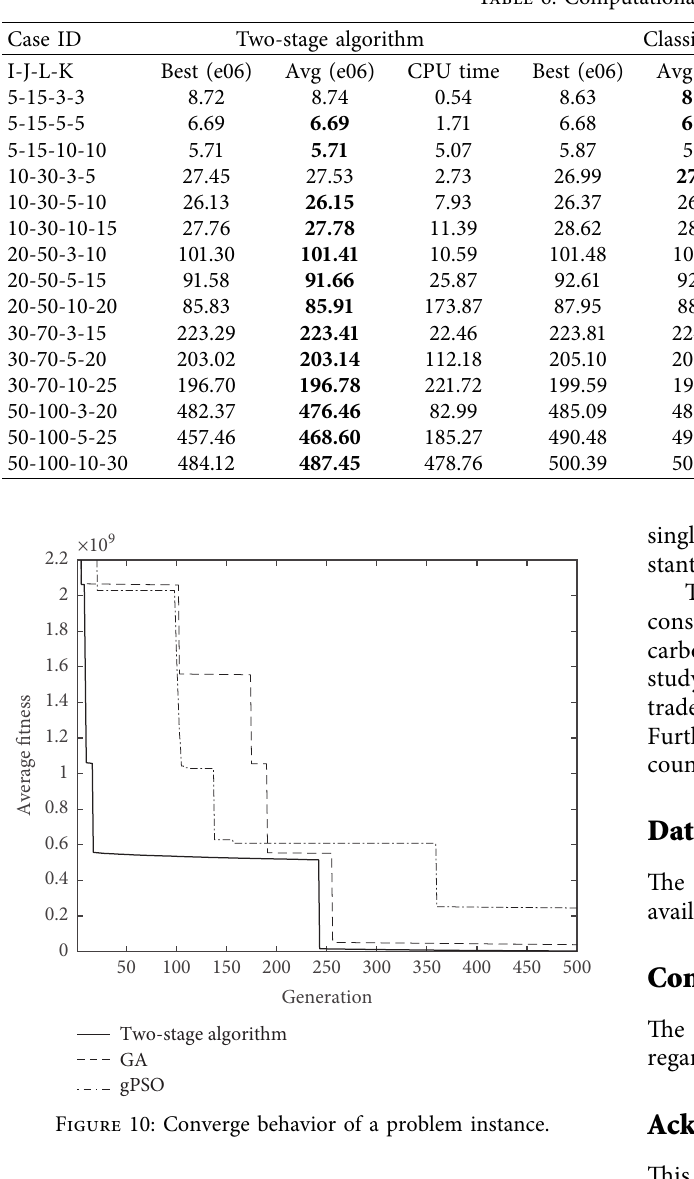
Table 6: Computational results.